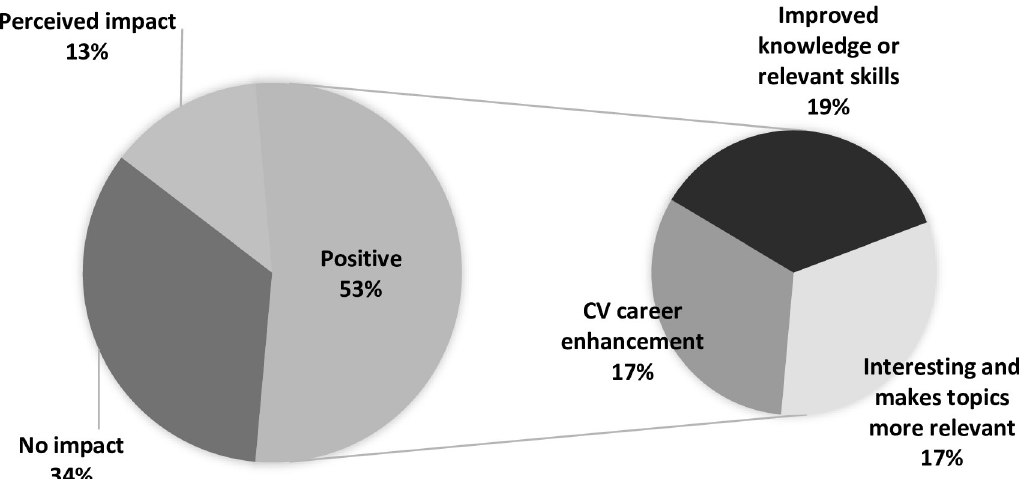
Fig 1. Pie of pie chart showing the impact of research on medical students. Across all 5 stages, there were 53 references or responses to the impact of research. Over half (53% of 53 responses) suggested that research had a positive impact. These positive impacts are represented in the second smaller pie chart. Approximately one third (34% of 53 responses) indicated no impact of research, predominantly because of lack of research experiences or occasionally because students did not see a role for research in their